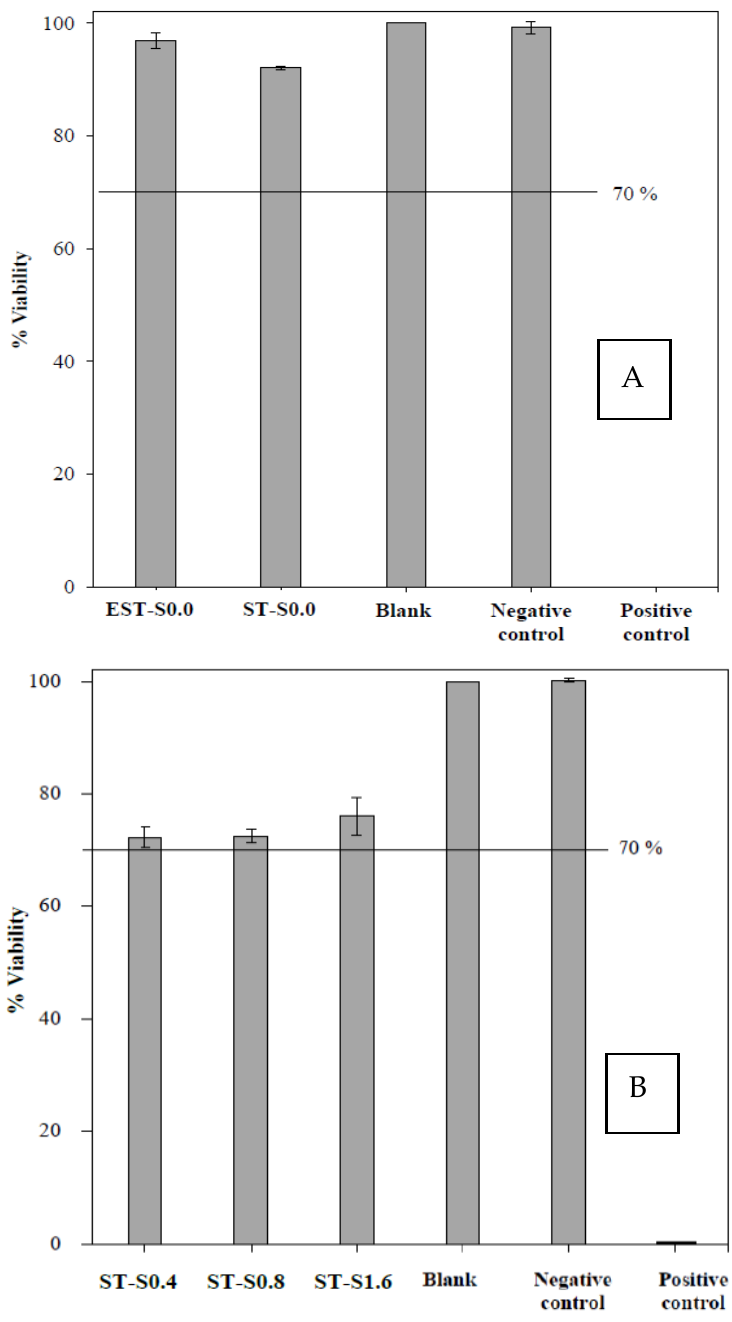
Figure 6. The biocompatibility on L929 mouse fibroblast cells: ( A ) the electrical treatment with non-ionic silver (EST-S0.0), the non-ionic and non-electrical treatment (ST-S0.0) in comparison to blank and controls; ( B ) the ionic silver treatments (ST-S0.4, ST-S0.8 and ST–S1.6) in comparison to blank and controls. The values are expressed as mean ± SD ( n = 3).